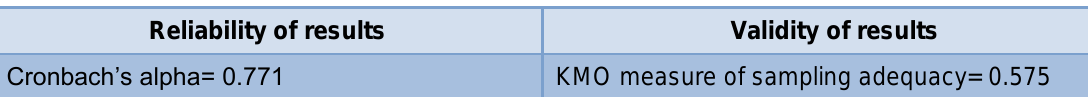
Table 2 Data reliability and validity